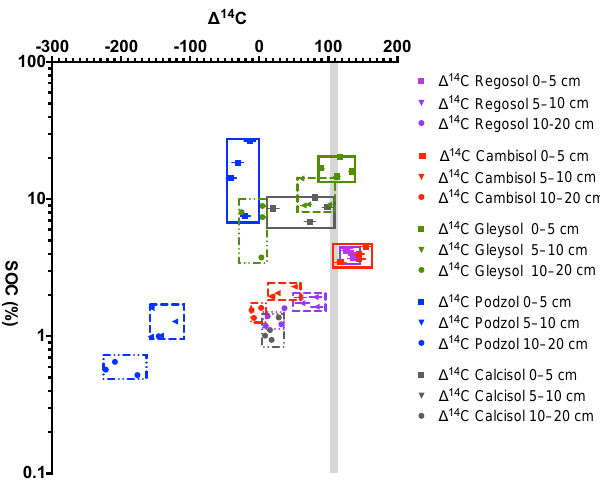
Figure 7. Spatial variability with depth (composites of each four cores, covering 400m 2 ) for five different soil types (Regosol, Cam- bisol, Gleysol Podzol and Calcisol) covering a gradient in eleva- tion and average air temperature (MAT 9.2–1.3 ◦ C, elevation 800– 1900m). The (cid:49) 14 C signature of atmospheric input at the time of sampling in indicated by grey shading (Hua et al., 2013). Variabil- ity in radiocarbon contents persists with depth and overlaps among soil types, while carbon contents differ among soil types and differ- ences decrease markedly with